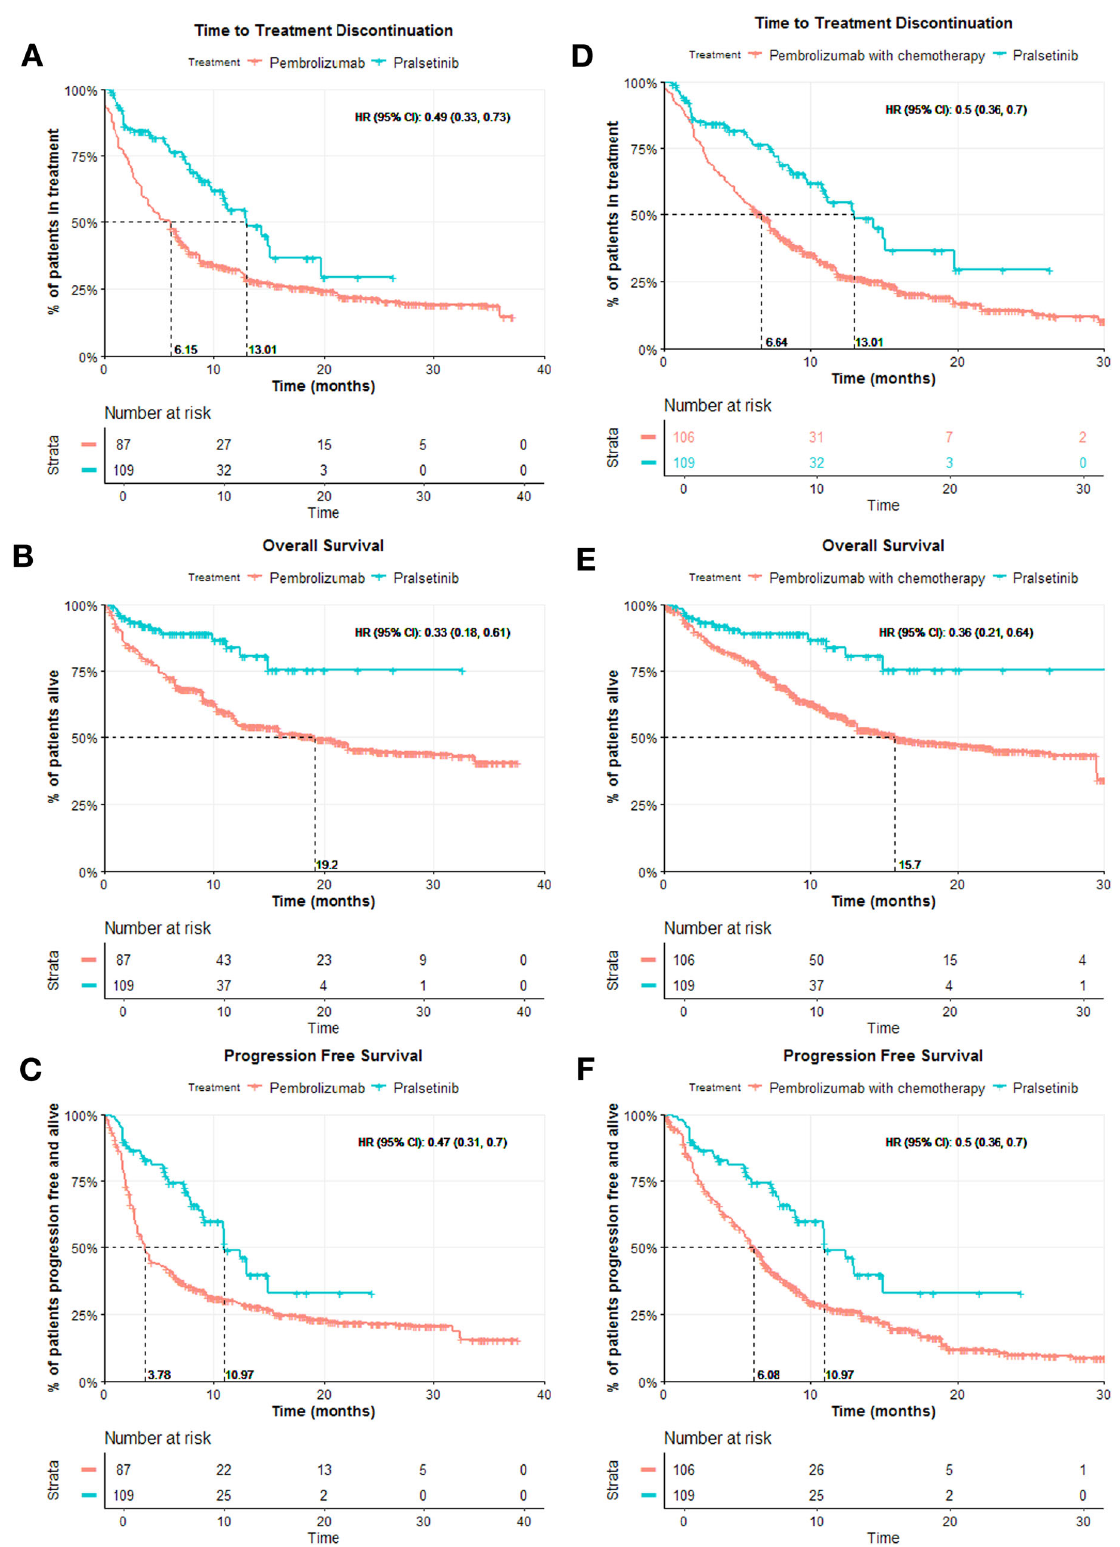
Fig. 1 Kaplan – Meier curves for TTD, OS, and PFS for comparisons between the 1 L pralsetinib trial cohort and 1 L pembrolizumab cohort, and 1 L pralsetinib trial cohort and 1 L pembrolizumab with chemotherapy cohort. A – C The Kaplan – Meier curves are for each endpoint TTD, OS, and PFS panels respectively for the comparison between 1 L pralsetinib versus 1 L pembrolizumab (ESS = 109 for the pralsetinib cohort, and ESS = 115 for the pembrolizumab cohort), and D – F for the comparison between 1 L pralsetinib versus 1 L pembrolizumab with chemotherapy after IPTW-adjustment (ESS = 109 for the pralsetinib cohort, and ESS = 217 for the pembrolizumab with chemotherapy cohort); the median OS for the pralsetinib cohorts could not be